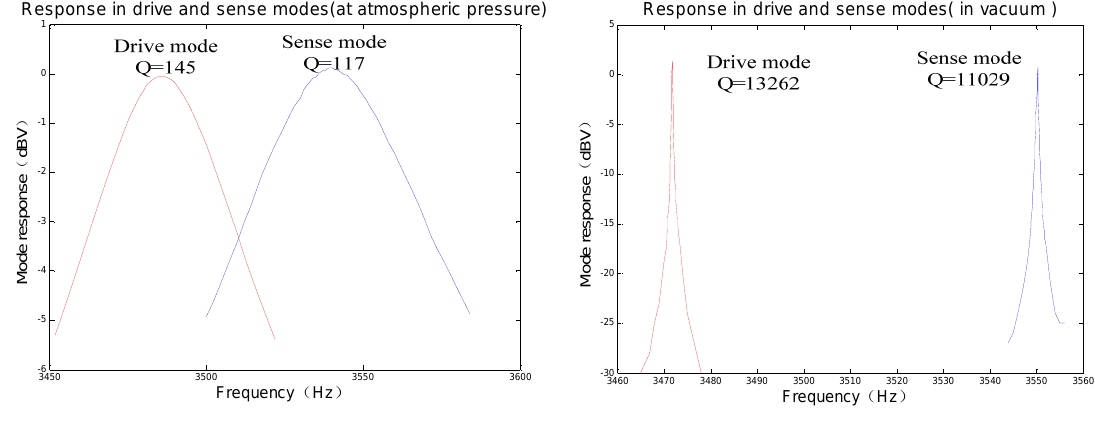
Figure 10. Response in drive and sense modes.